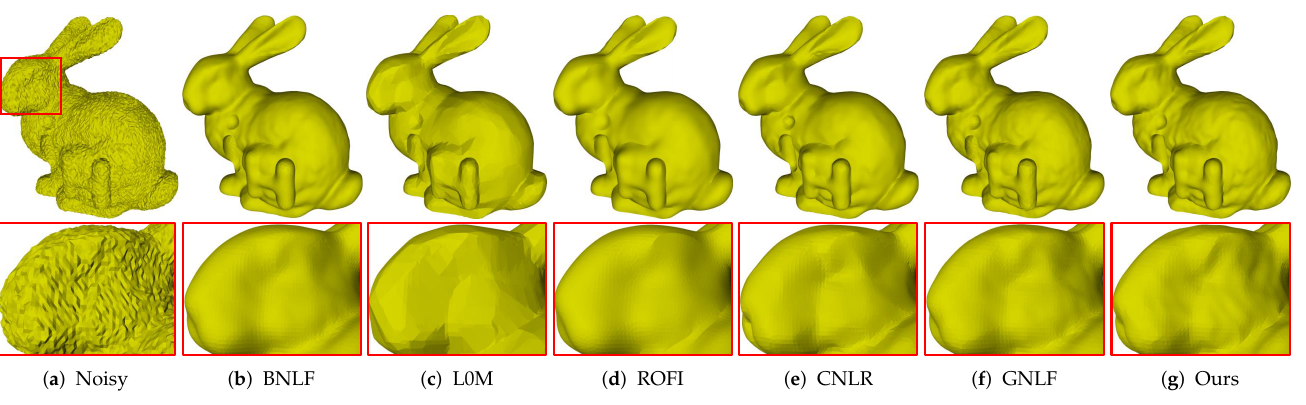
Figure 6. Denoising results of Bunny